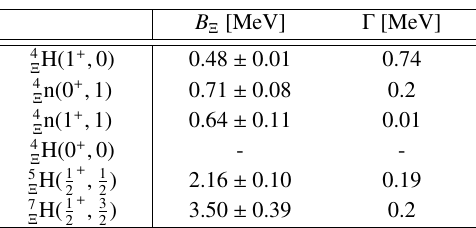
Table 3: Ξ separation energies B Ξ and estimated decay widths Γ for A = 4 − 7 Ξ hypernuclei. All calculations are based on the NLO(500) YY- Ξ N interaction and the SMS N 4 LO + (450) NN potential. Both interactions are SRG-evolved to a flow parameter of λ NN = λ Ξ N = 1 . 6 fm -1 . The values of B Ξ in NNN Ξ , 5 Ξ H and 7 Ξ H are measured with respect to the binding energies of the core nuclei 3 H, 4 He and 6 He,